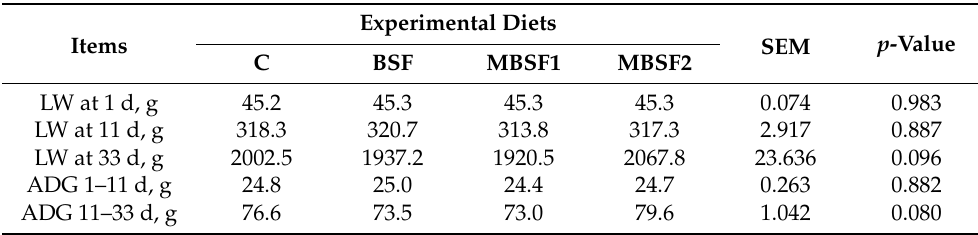
Effect of black soldier fly larvae fat on growth performance of broiler chickens (n = 5 pens/treatment; 10